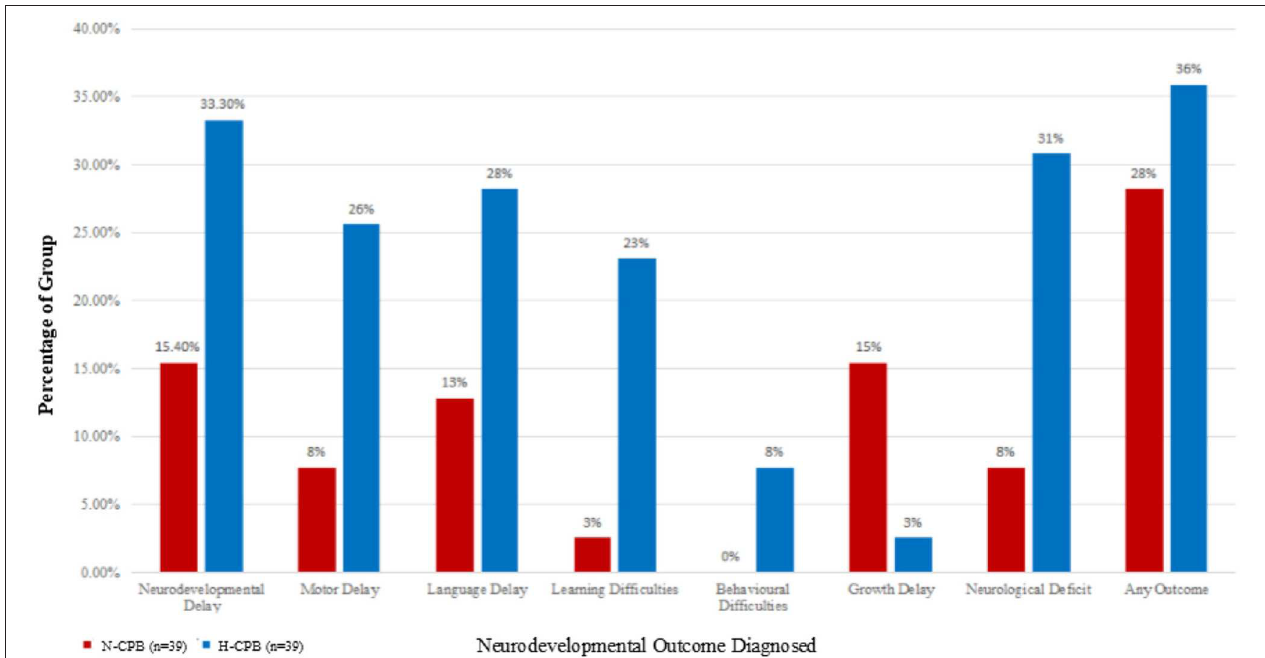
FIGURE 1 | The percentages of each group who have been diagnosed with an adverse neurodevelopmental outcome a few years after surgery.